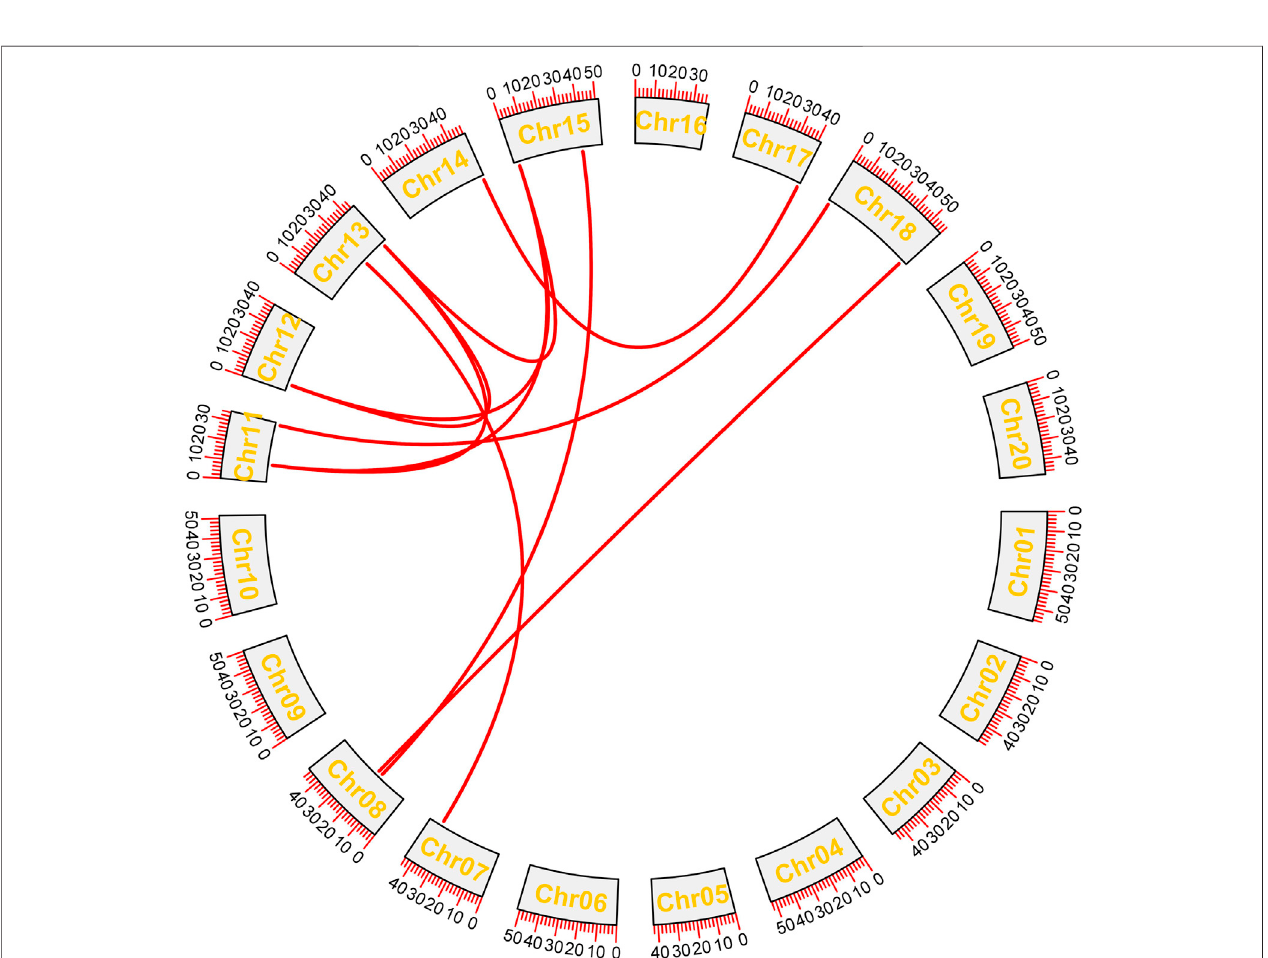
FIGURE 3 | Gene duplication analyses of GmHH3 . Red lines show the duplication of genes on different chromosomes.